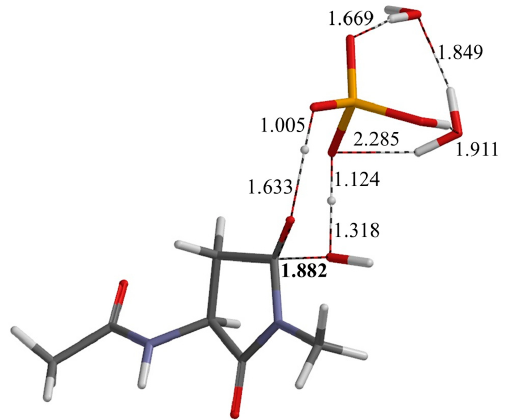
Figure 7. The geometry of the second-step transition state (TS2). This transition state is for dehydration, and connects IC2 (Figure 6) and the PC (Figure 8). Selected interatomic distances are shown in Å. Grey: carbon; white: hydrogen; blue: nitrogen; red: oxygen; orange: phosphorus.